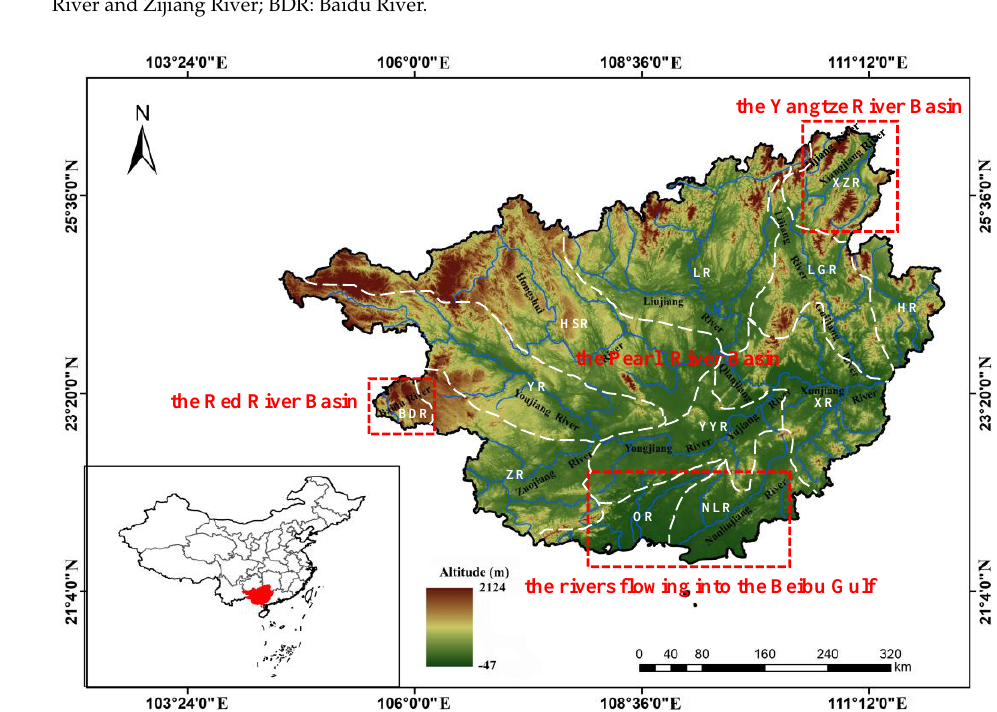
Figure 1. General situation of the freshwater system and Sub − basins in Guangxi. The white dotted lines represent sub − basin boundaries. Sub − basin codes are described in Table 1.